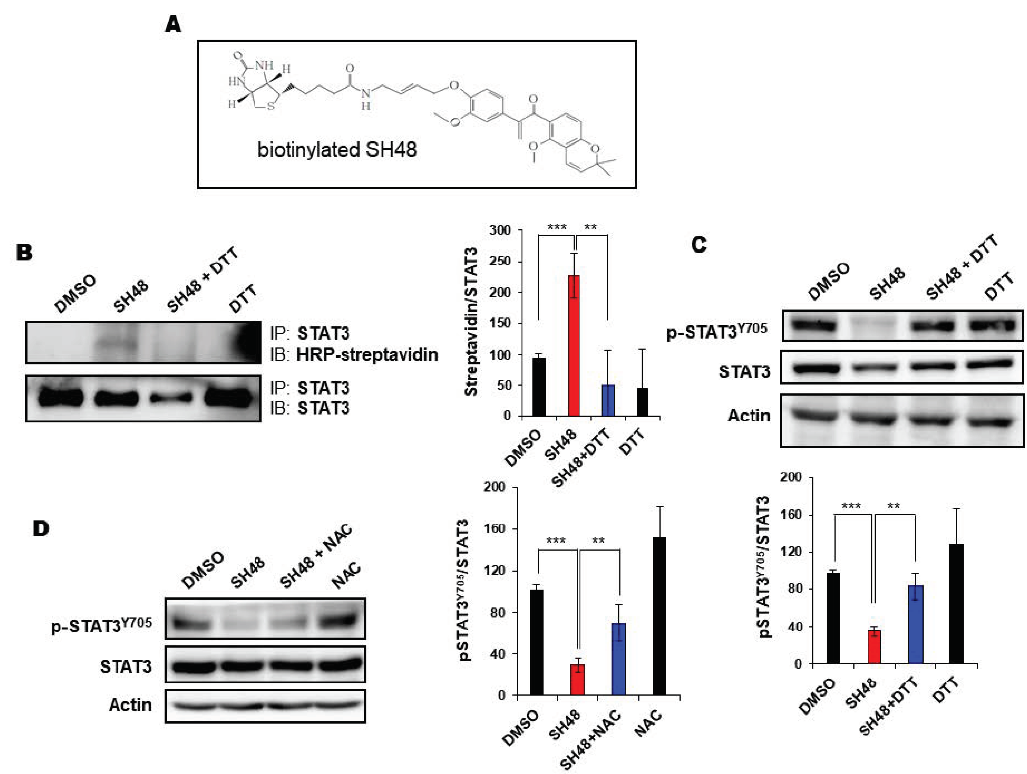
Figure 4. Effects of thiol reducing agents on interaction of SH48 with STAT3 and phosphorylation of STAT3. ( A ) Structure of biotinylated SH48. ( B ) MCF10A- ras cells were incubated with 30 for 24 h.